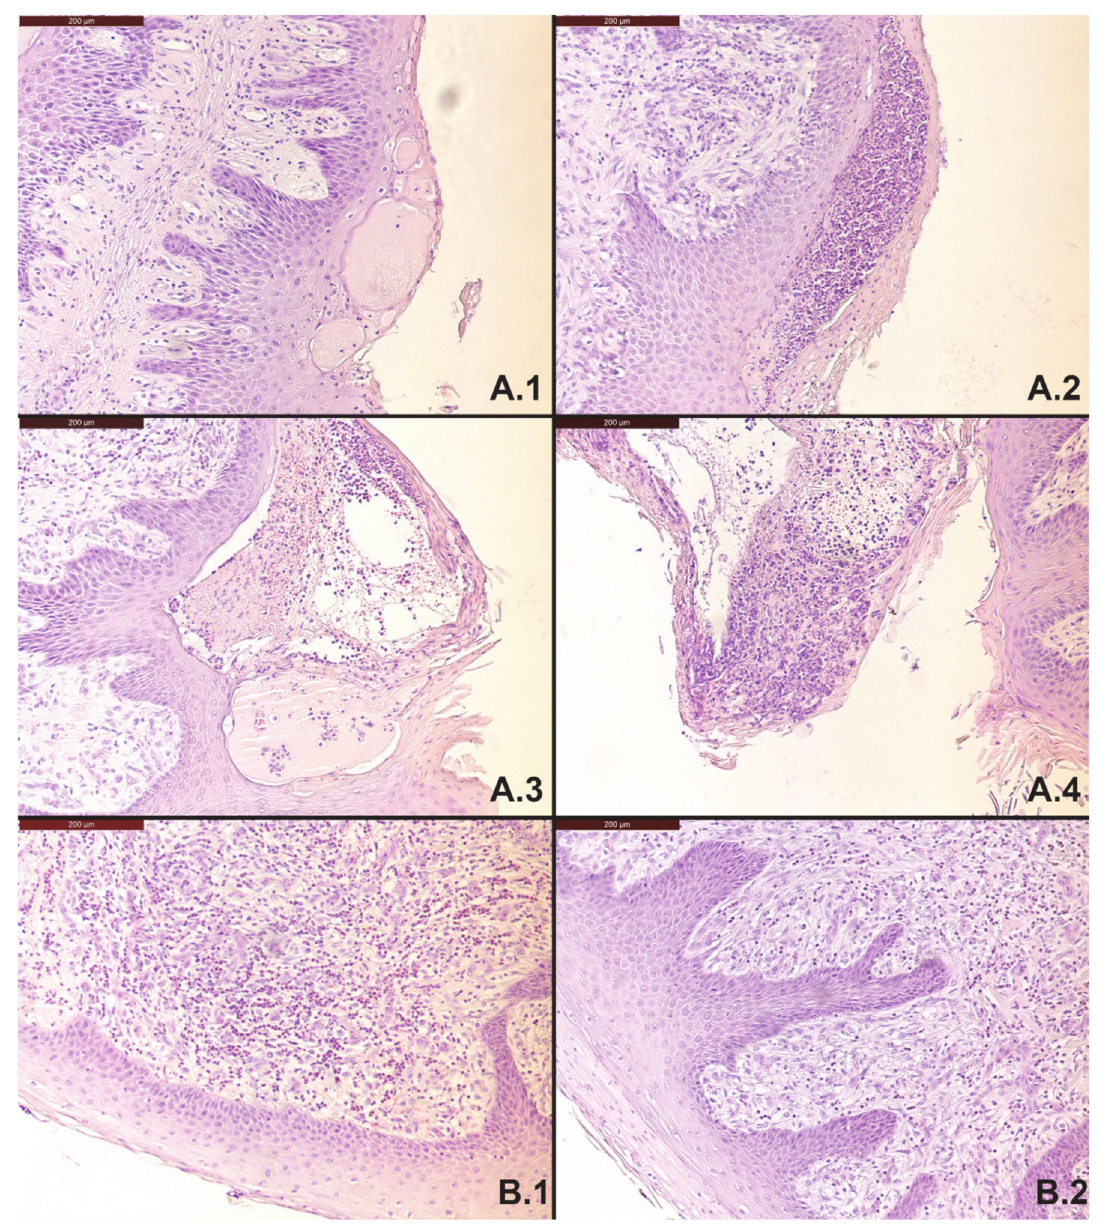
Figure 2. ( A.1 – A.4 ) Histological examination of the rumen wall of cow L1 on parts with a reduced amount of papillae; remaining papillae show formation of exudate filled blisters in the epithelial layer ( A.1 ), and invasion of inflammatory cells (polymorphonuclear leukocytes) into these cavities forming micro-abscesses ( A.2 , A.3 ), which leads to ulceration and papillary necrosis ( A.4 ). ( B.1 , B.2 ) Histological examination of the rumen wall of cow L6 on local spots with missing rumen papillae and thickening of the rumen wall, and invasion of polymorphonuclear leukocytes ( B.1 ), sometimes combined with hyperkeratosis ( B.2